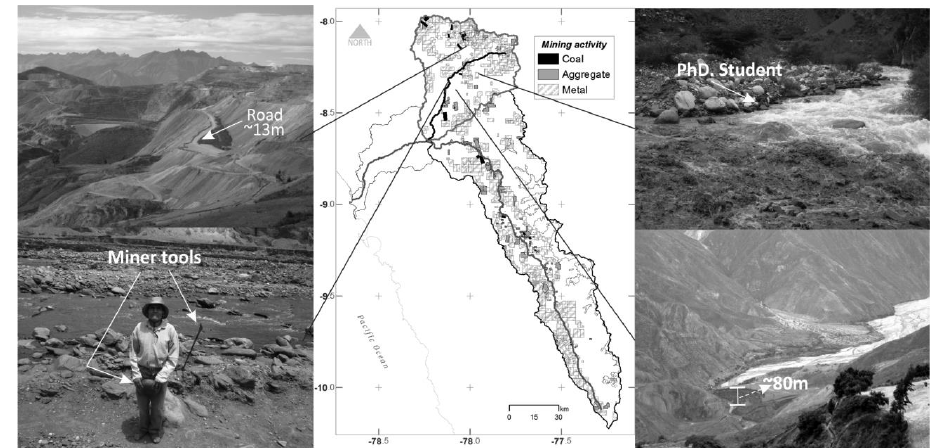
Fig. 3. The boom in large-scale mining in the upper basin (upper left) and an artisanal miner panning for gold during the dry season in the Tablachaca River (lower left). Distribution of mining concessions in the Santa River Basin (centre). The strong contrast between the higher SSC load carried by the Tablachaca River (left) and the lower SSC load in the Conchucos River (right) during the rainy season (upper right) and a landslide from the Chimu Formation creating a natural dam in the river bed many years ago (lower right).